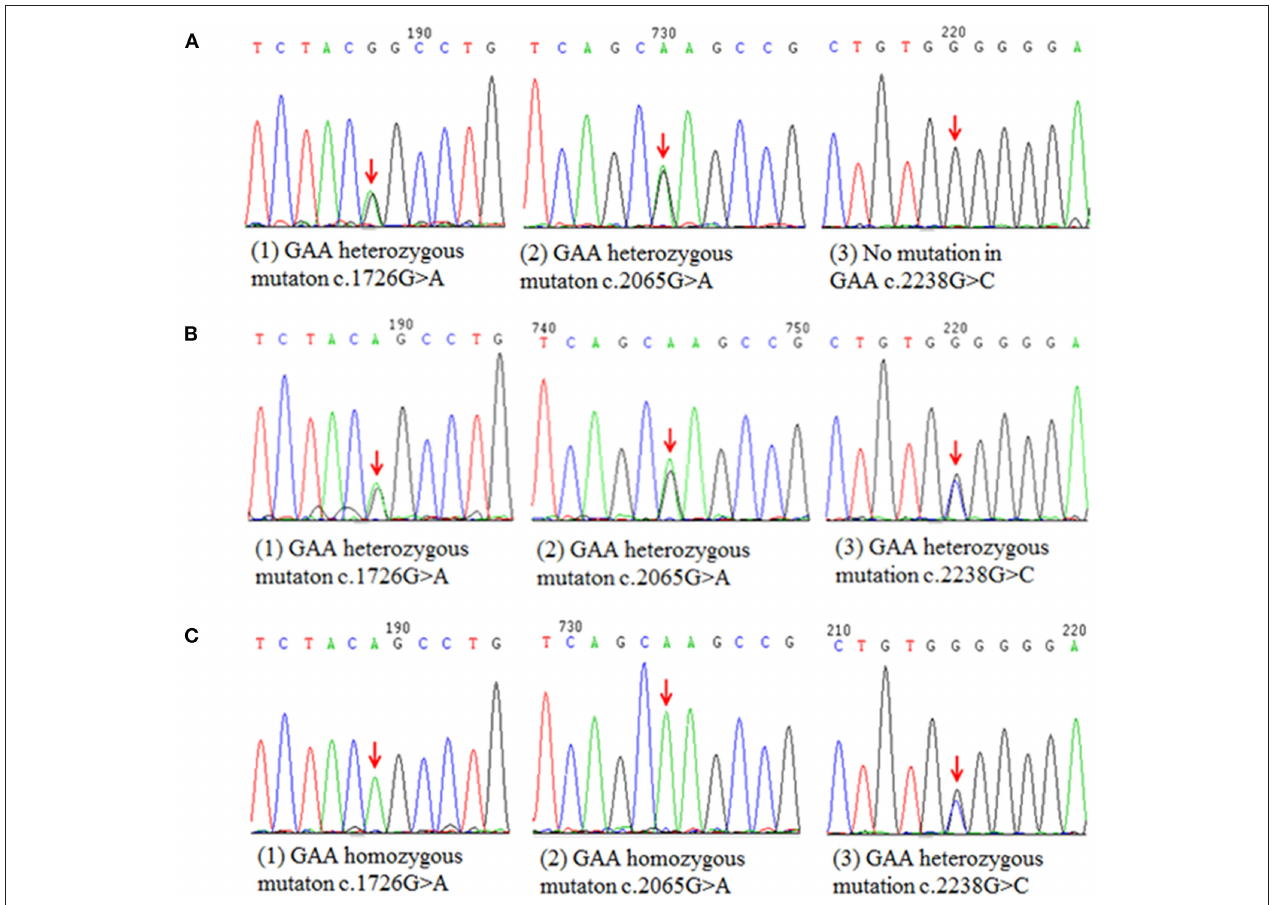
FIGURE 3 | Schematic diagram of the mutation sites of patient’s parents and elder sister. (A) Two compound heterozygous mutations detected in patient’s farther for c.1726G > A (p.Gly576Ser) and c.2065G > A (p.Glu689Lys). (B) The patient’s mother was heterozygous for c.1726G > A (p.Gly576Ser), c.2065G > A (p.Glu689Lys), and c.2238G > C (p.Trp746Cys) mutations. (C) The patient’s elder sister was homozygous for c.1726G > A (p.Gly576Ser) and c.2065G > A (p.Glu689Lys) mutations and heterozygous for c.2238G > C (p.Trp746Cys)